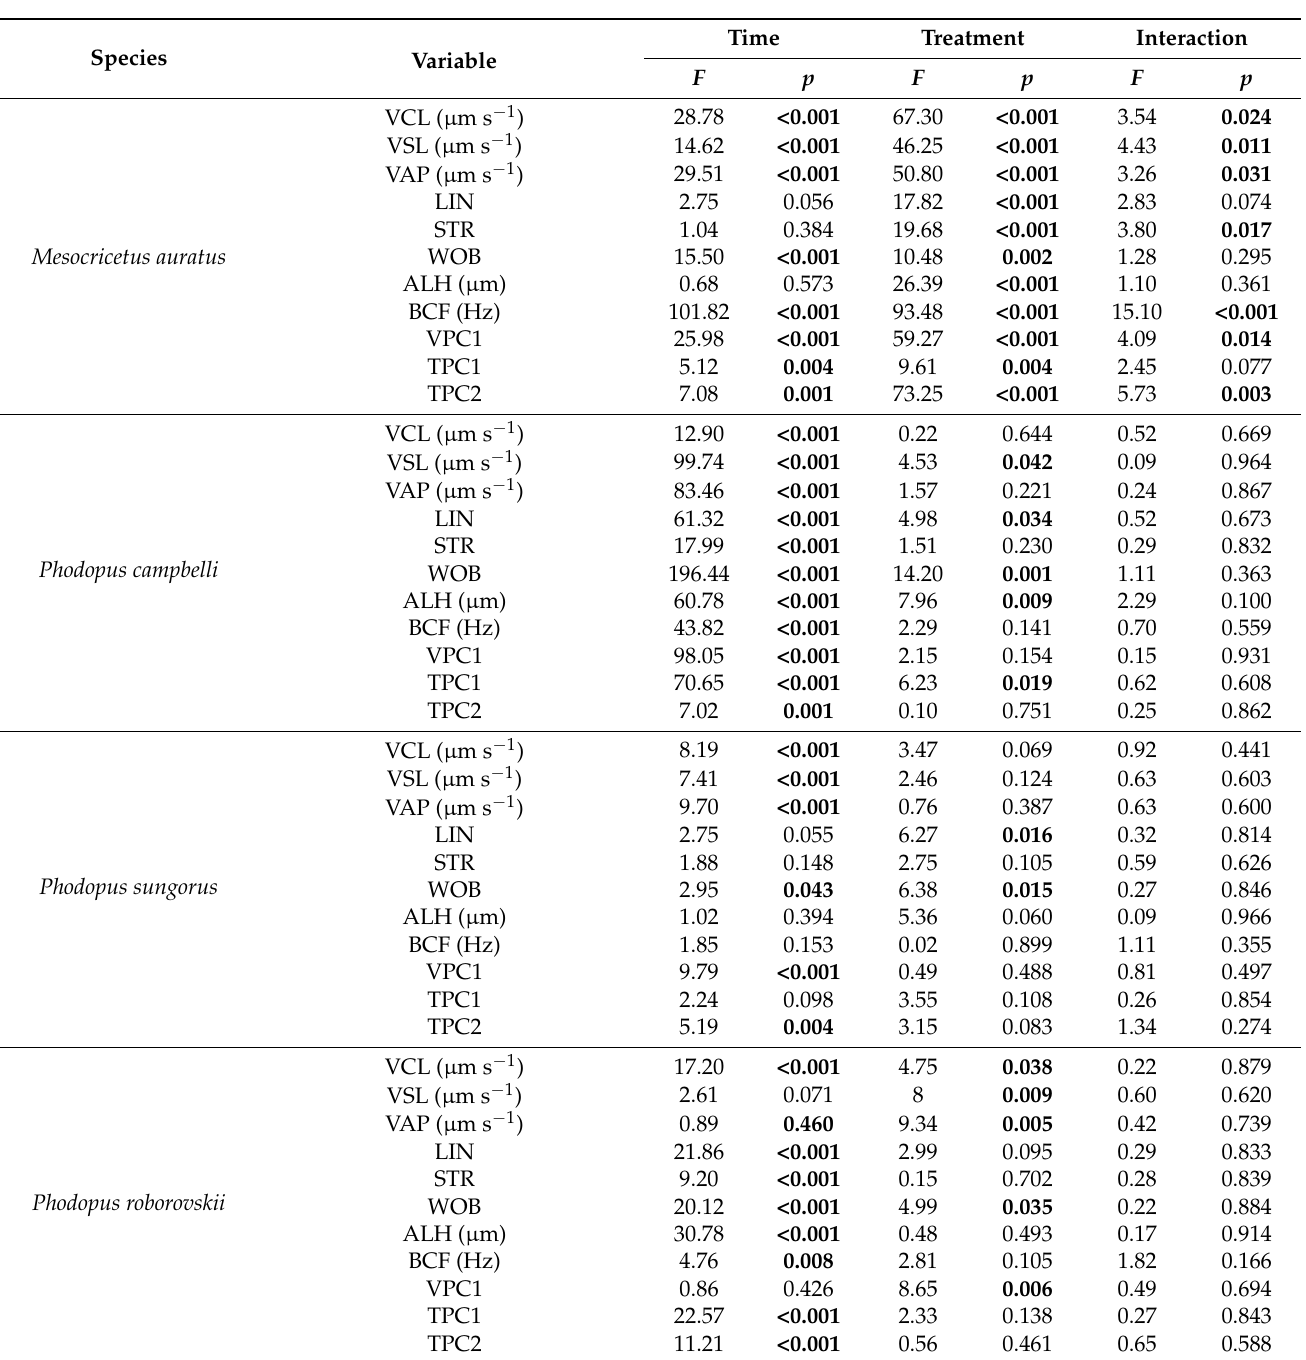
Table 6. Effect of penicillamine, hypotaurine and epinephrine (PHE) on sperm velocity and trajectory shape parameters in four hamster species. F and p values correspond to repeated measures ANOVA using time of incubation and treatment (control vs. PHE) as independent variables, and sperm parameters as dependent variables. VCL: curvilinear velocity. VSL: straight-line velocity. VAP: average path velocity. LIN: linearity. STR: straightness. WOB: wobble coefficient. ALH: amplitude of lateral head movement. BCF: beat-cross frequency. VPC1: velocity principal component 1. TPC1: trajectory shape principal component 1. TPC2: trajectory shape principal component 2.